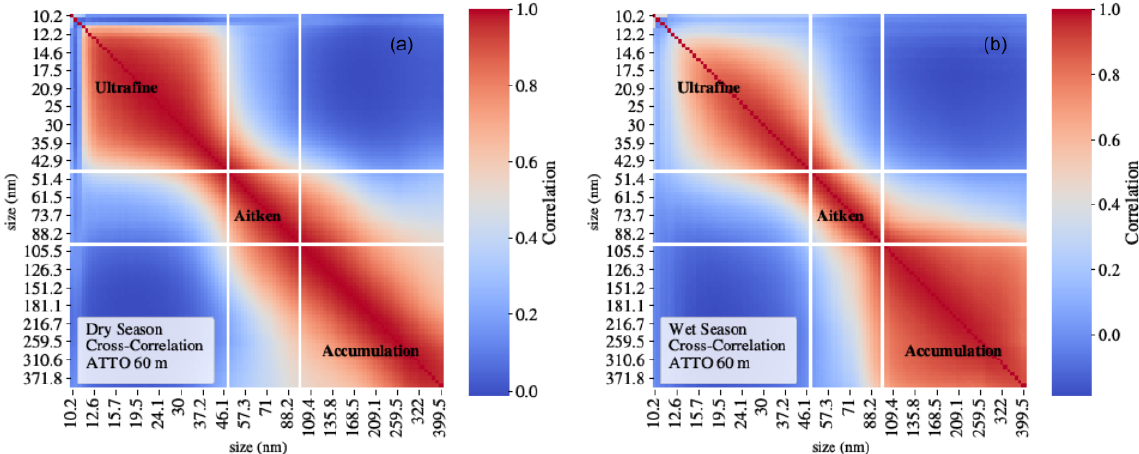
Figure 1. Particle number size distribution cross-correlation sampled at 60m height at ATTO. (a) Dry season (June to October) and (b) wet season (December to April). The cross-correlation underlines the distinction into ultrafine, Aitken and accumulation